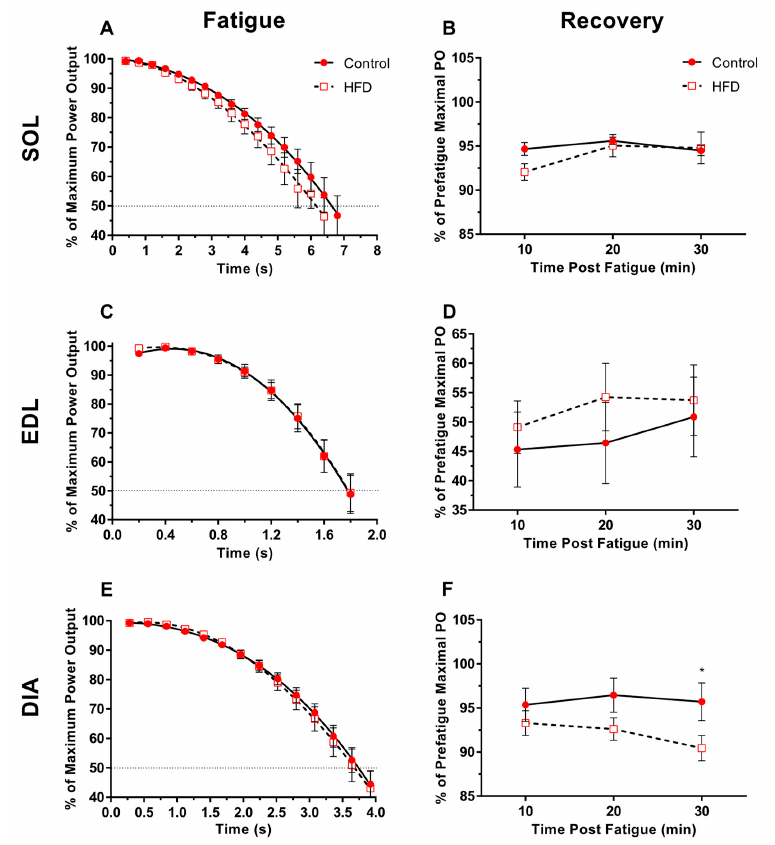
Figure 5. The effect of 9 weeks of a HFD on the fatigue resistance ( A , C & E ) and recovery of power ( B , D & F ) of maximally stimulated mouse soleus ( A & B ), EDL ( C & D ) and diaphragm ( E & F ) for the control and HFD groups. Values presented as mean ± S.E.M. A * denotes a significant ( P < 0.05) difference in recovery of power between experimental groups at a given time point.